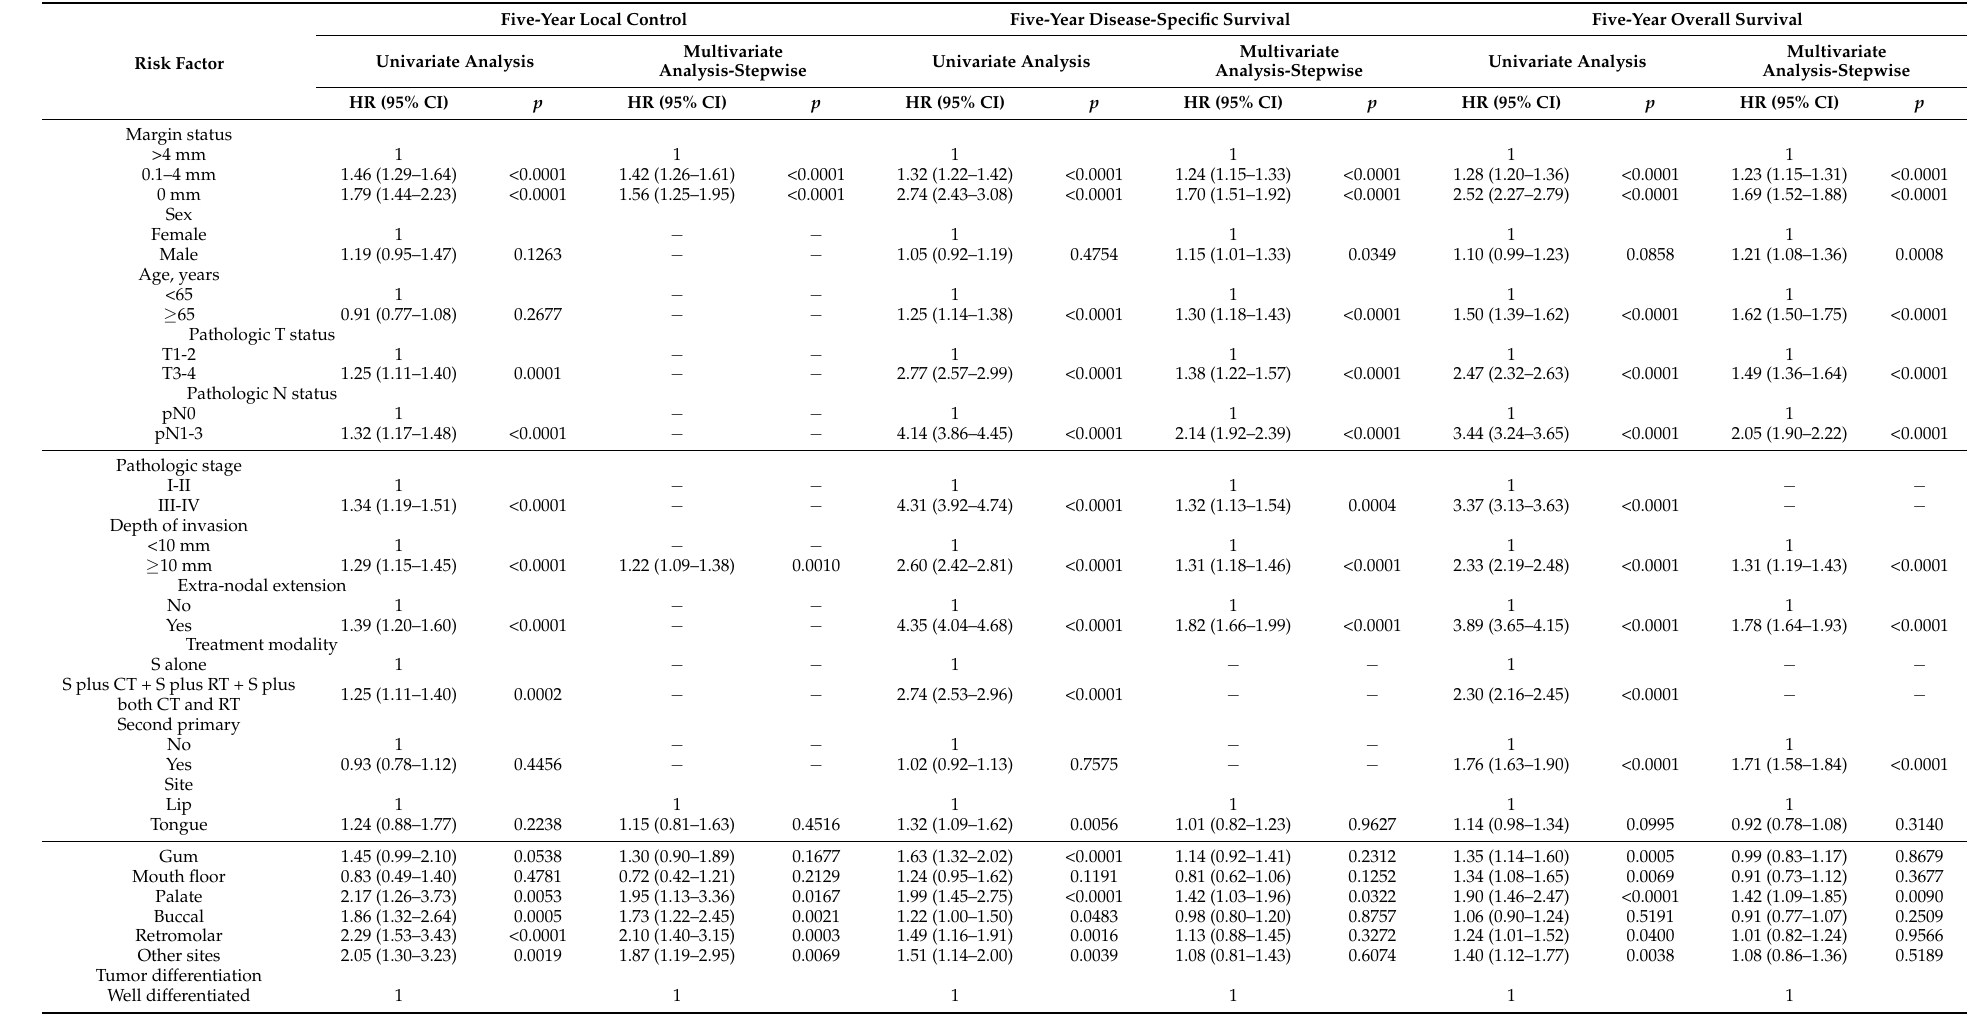
Table 2. Univariate and multivariate analyses of different outcome